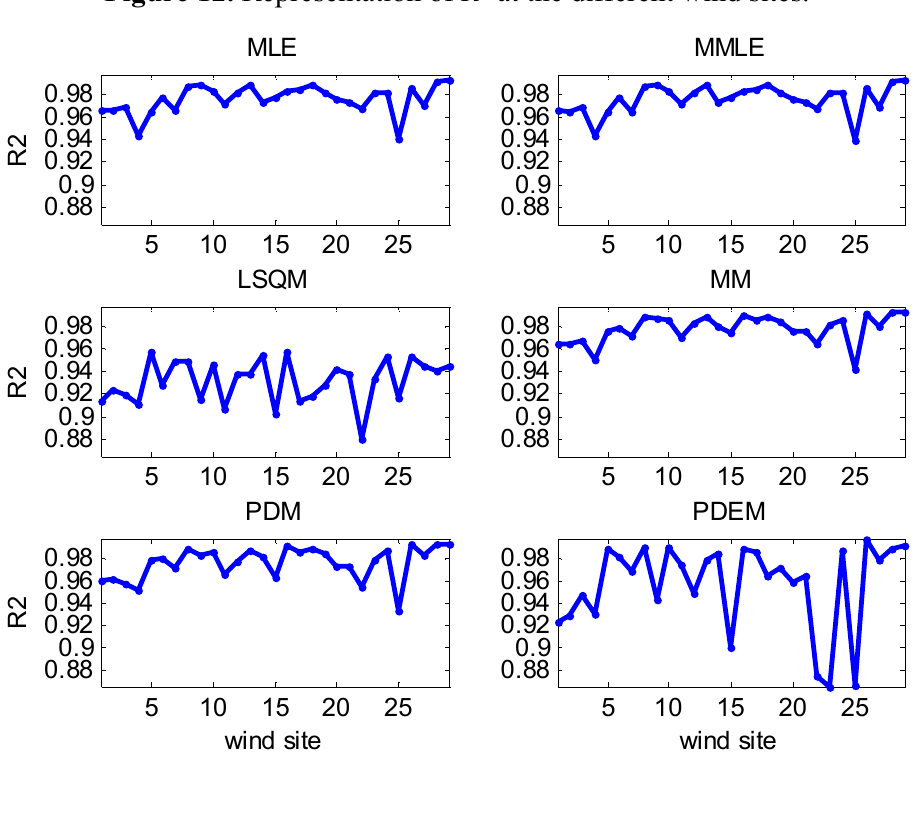
Figure 12. Representation of R 2 at the different wind